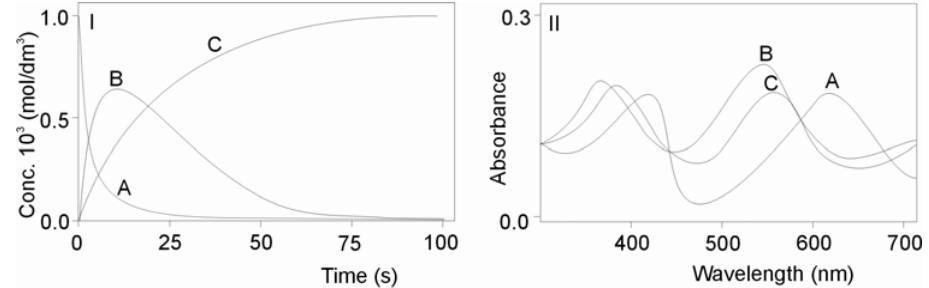
Figure 2. Results of the kinetic ( I ) and spectral ( II ) analysis for reactants: ( I ) Concentration curves of the decomposition of substrate A: cis -[Cr(C formation of product C: cis -[Cr(C B; ( II ) Absorption spectra of the reactants A, B and C.